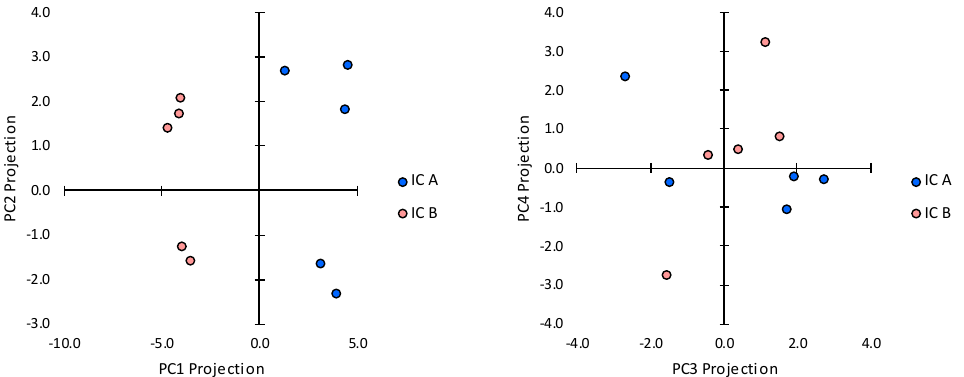
Figure 8. Principal component projections of immune cell cluster samples microdissected from ( A ) the subgroup P.G5.B gland (positive PC1 projection in Figure 2) and ( B ) the subgroup P.G5.A gland (negative PC1 projection in Figure 2).